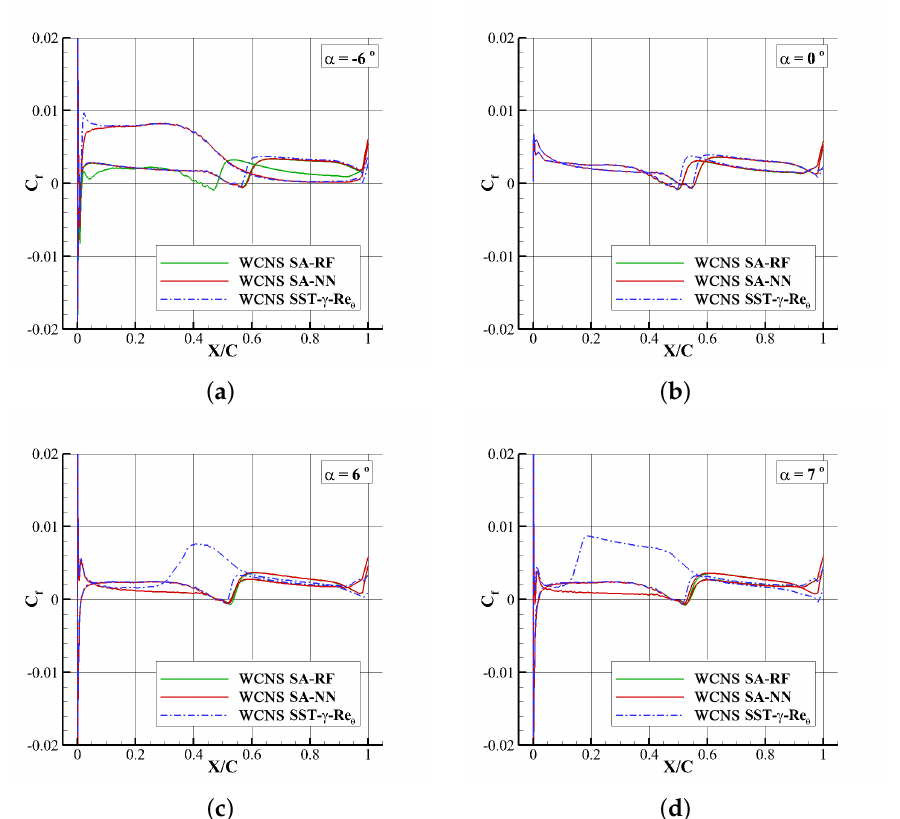
Figure 11. Fractional drag coefficient (angle of attack from − 6 ◦ to 9 ◦ ). ( a ) a = − 6 ◦ . ( b ) a = 0 ◦ . ( c ) a = 6 ◦ . ( d ) a = 7 ◦